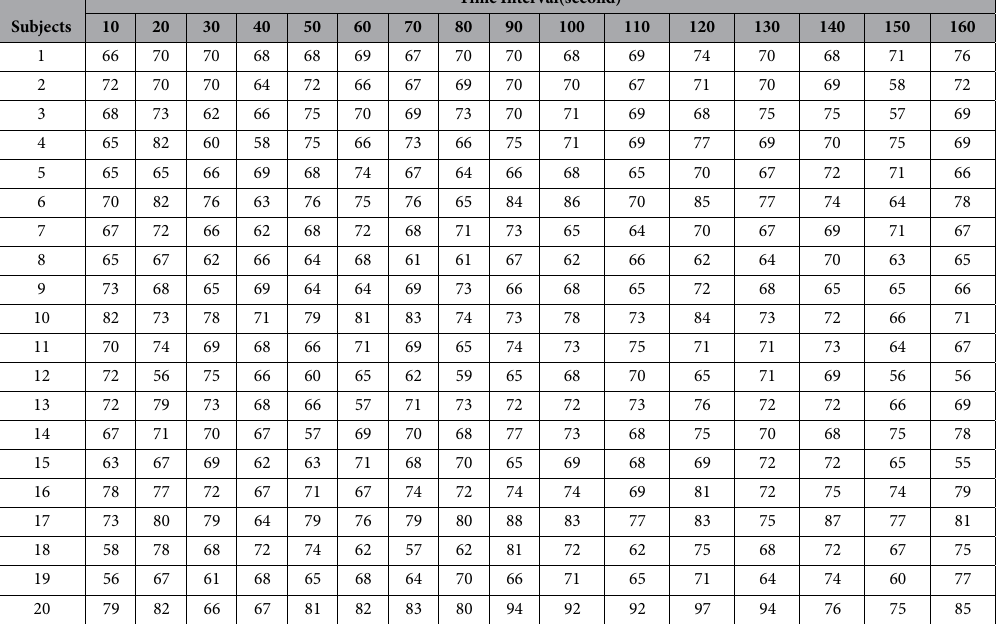
Table 2. The bpm of 20 subjects down-sampled to 10 second intervals for presentation. The variation of HR measurement is still clear for all subjects at ten second of time interval.